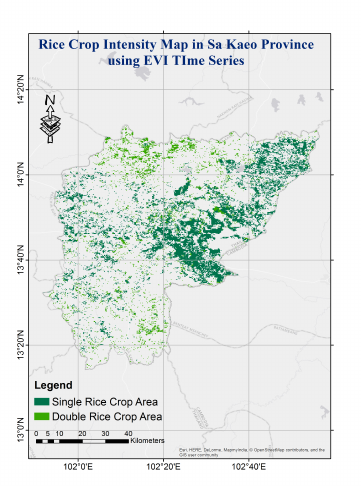
Figure 11: Single rice crop area start-of-season in Sa Kaeo Province, using EVI